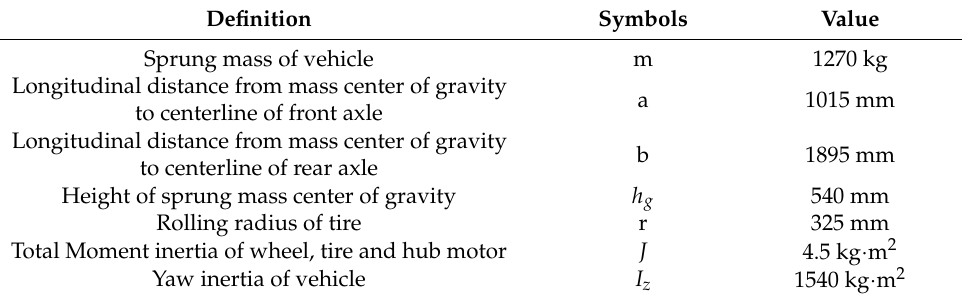
Table 2. Key parameters of the 4WD BEV.